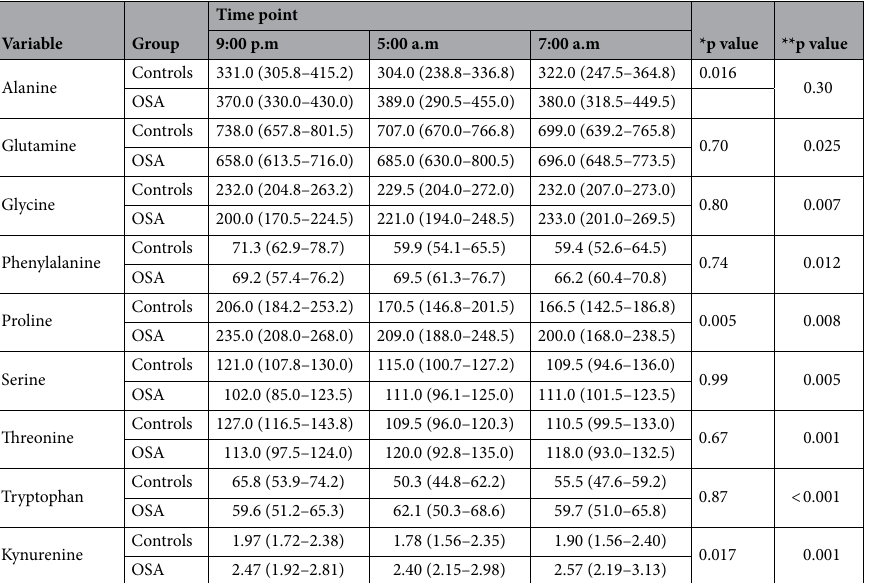
Table 2. The results of overnight measurements of amino acids and biogenic amines in the sera of patients with moderate-to-severe obstructive sleep apnea (OSA) and control individuals at three time points: 9:00 p.m., 5:00 a.m. and 7:00 a.m. and the p -values of two separate ranked general linear model for repeated measures analyses. Concentrations are expressed as μmol/L (interquartile range). Statistical analysis has been performed with rank general linear model for repeated measures. The model was adjusted to body mass index, age, gender, current smoking status, oxygen desaturation index including only desaturations with at least 5% drop in oxygen saturation; oxygen desaturation index including only desaturations extending below 90% and serum contents of potassium, sodium, aspartate aminotransferase, alanine aminotransferase, urea, high-density lipoprotein cholesterol, low-density lipoprotein cholesterol and triglycerides. * p values refer to between-group differences for serum concentrations of the variables between patients with moderate-to-severe OSA and control individuals. ** p values indicate time-dependent effects with time-by-group interactions for serum concentrations of the biomarkers referring only to the differences for the dynamics of the respective substances overnight between patients with moderate-to-severe OSA and control